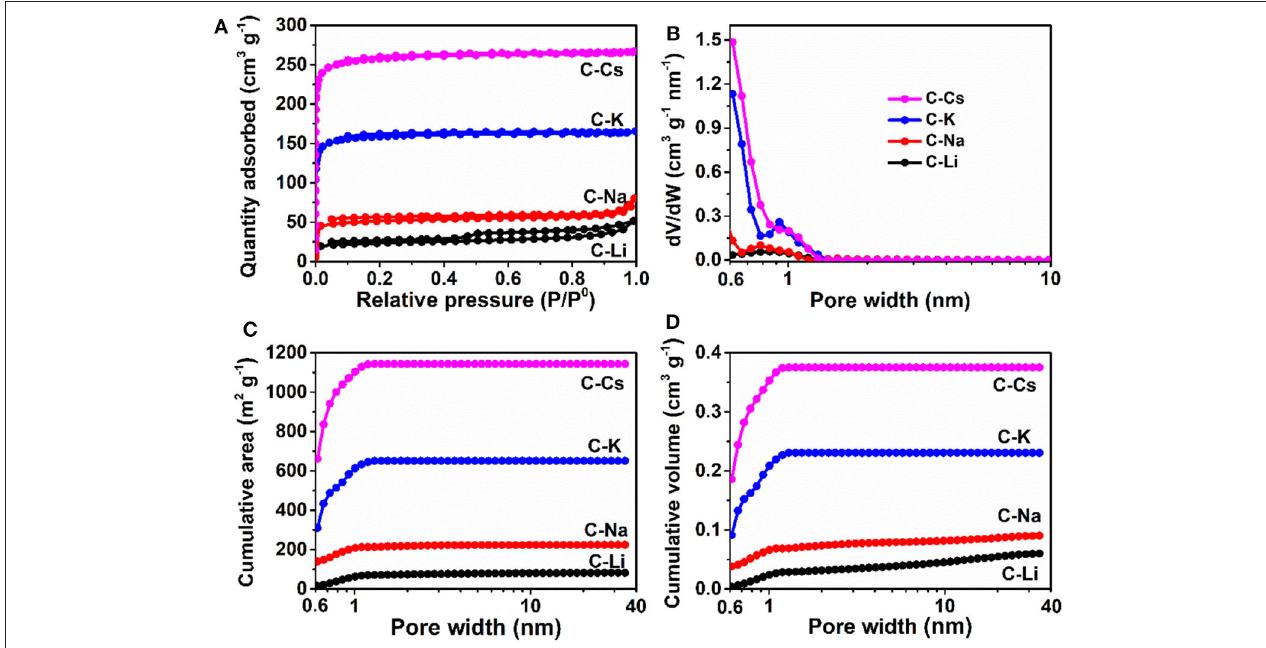
TABLE 1 | Porosity parameters and element composition by X-ray photoelectron spectroscopy of the carbon samples. Sample Porosity parameters Elemental composition by X-ray photoelectron